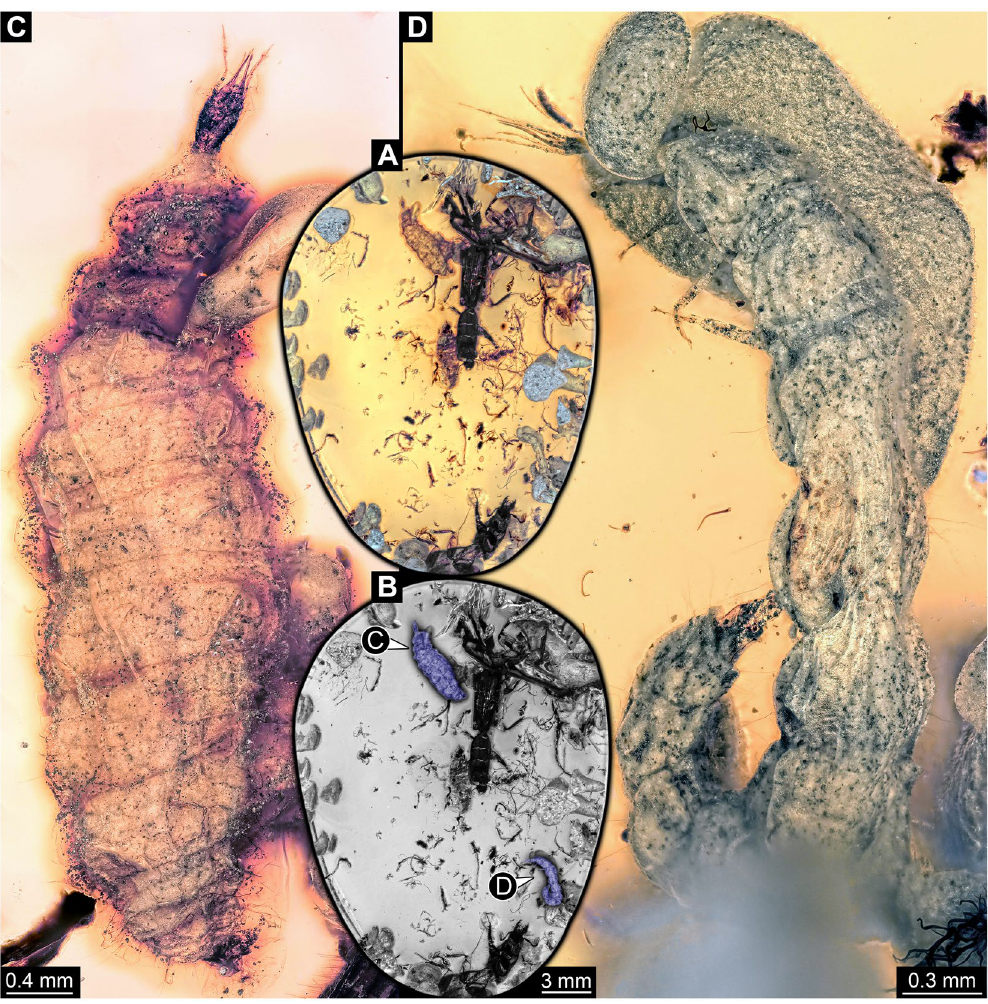
Figure 2. PED 1794, Kachin amber. ( A ) Overview of amber piece. ( B ) Desaturated version of A with the two lacewing larvae colour-marked. ( C ) Lacewing larva 1, dorsal view. ( D ) Lacewing larva 2, dorso-lateral